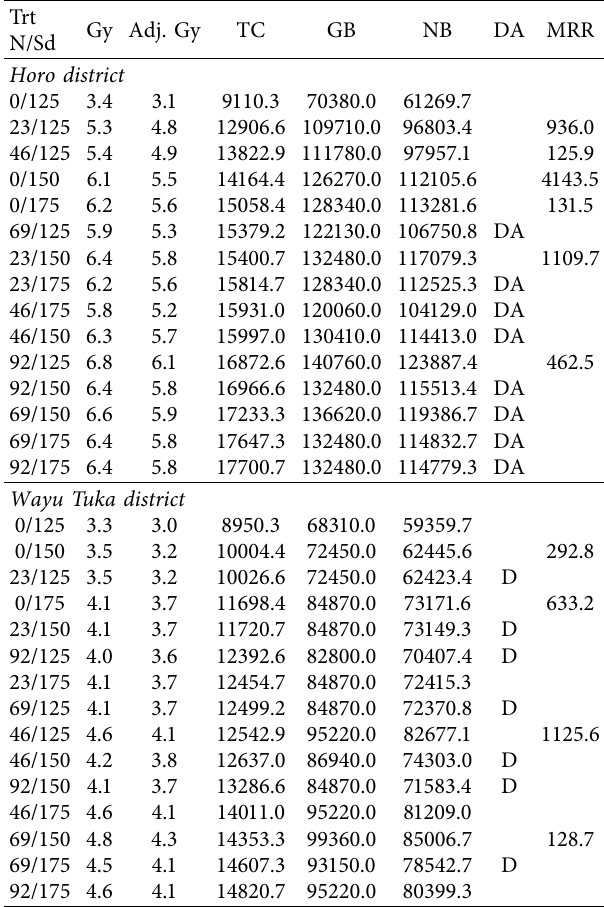
Table 9: Te efects of N fertilizer application and seed rate on the economic proftability of bread wheat production at Horo and Wayu Tuka districts during 2020 under irrigation